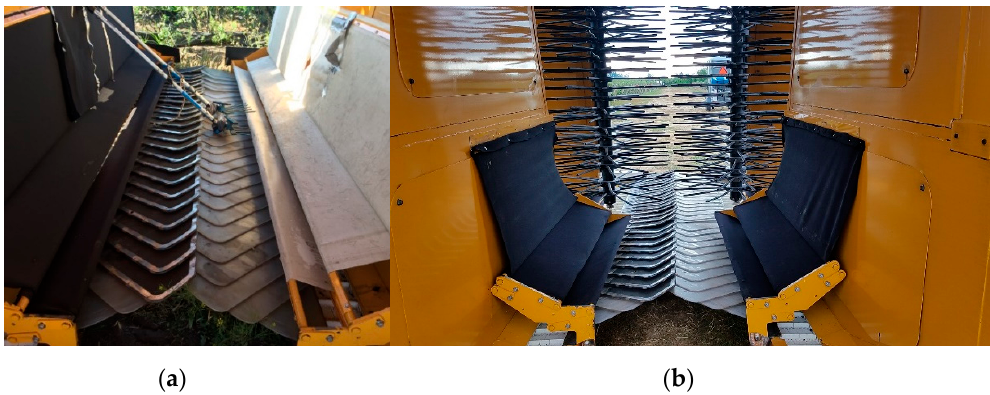
Figure 1. Modifications to an Oxbo 7420 machine harvester for fresh market blueberry. The harvester in Oregon had a neoprene soft catch surface suspended above the conveyor belt and hollowed out catch plates with neoprene installed on the top side of each catch plate (left; a ). A canvas catch surface was installed over the conveyor belt with standard plastic catch plates on the other side of the machine (right; a ). In Washington, both sides of the machine had neoprene catch surfaces, but the catch plates were the same as in Oregon ( b ). Hand held pneumatic shakers were used to harvest ‘Duke’ and ‘Draper’ blueberries in Oregon. ‘Elliott’ and ‘Aurora’ blueberries were harvested with Orbirotor ® picking heads (i.e., rotary drum shakers) in Washington.